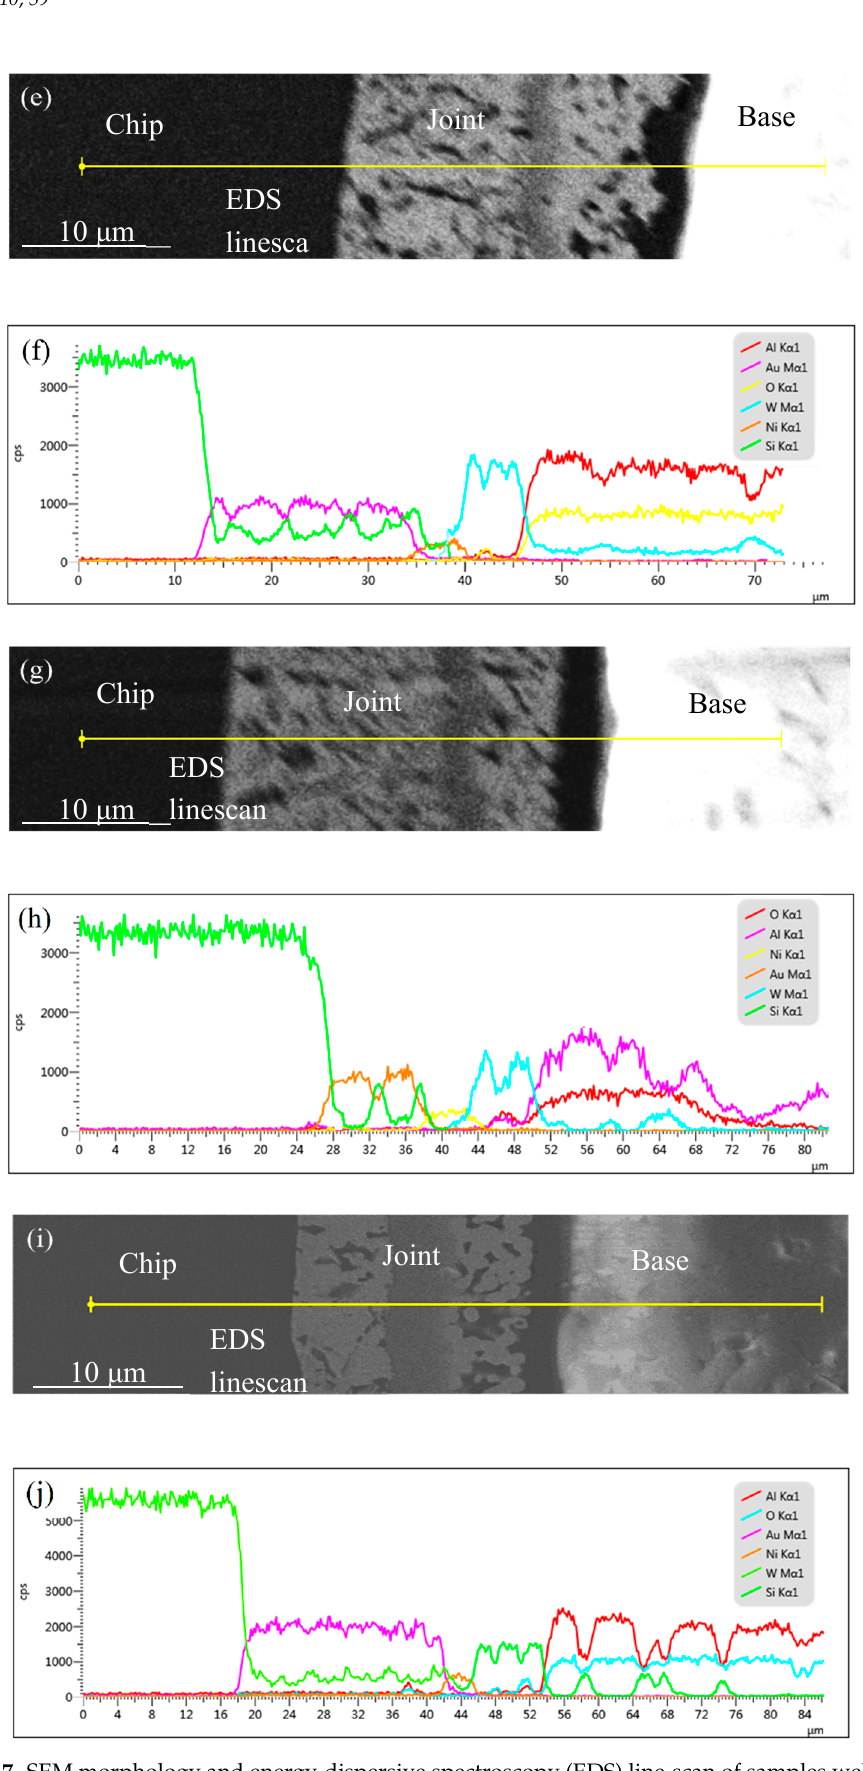
Figure 7. SEM morphology and energy-dispersive spectroscopy (EDS) line-scan of samples welded at 360 ◦ C ( a , b ) and 380 ◦ C ( c , d ). SEM morphology and EDS line-scan of samples welded at 400 ◦ C ( e , f ), 420 ◦ C ( g , h ), and 440 ◦ C ( i , j